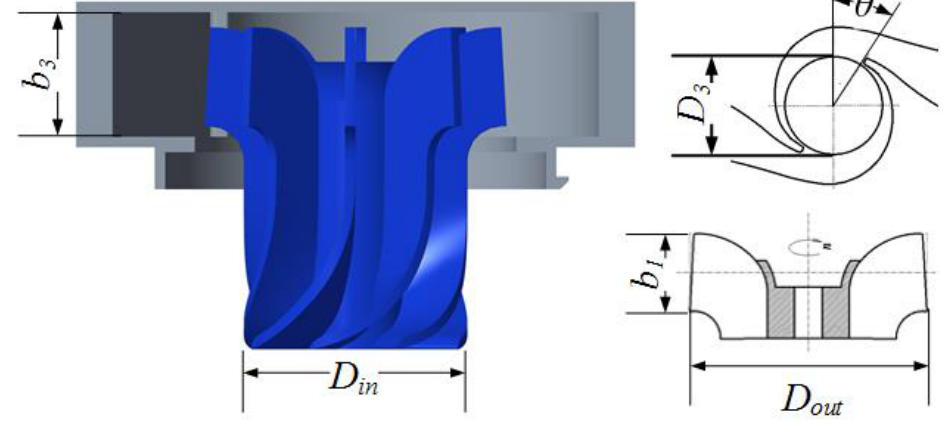
Figure 2. Dimension labeling of dishwasher pump.